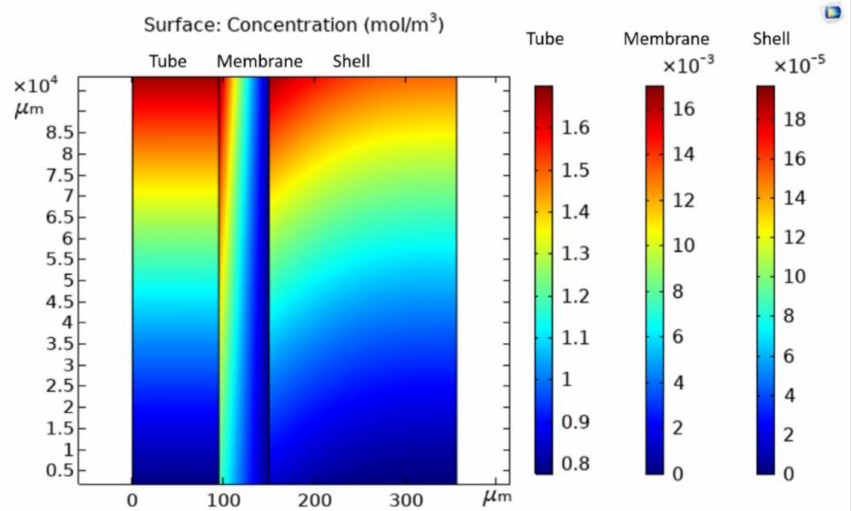
Figure 4. Distribution of concentration of water vapor in three domains of a hollow fiber mem- brane (air velocity = 0.037 m/s, initial concentration of water vapor = 1.72 mol/m 3 , and vacuum pressure = 77.9 kPa).